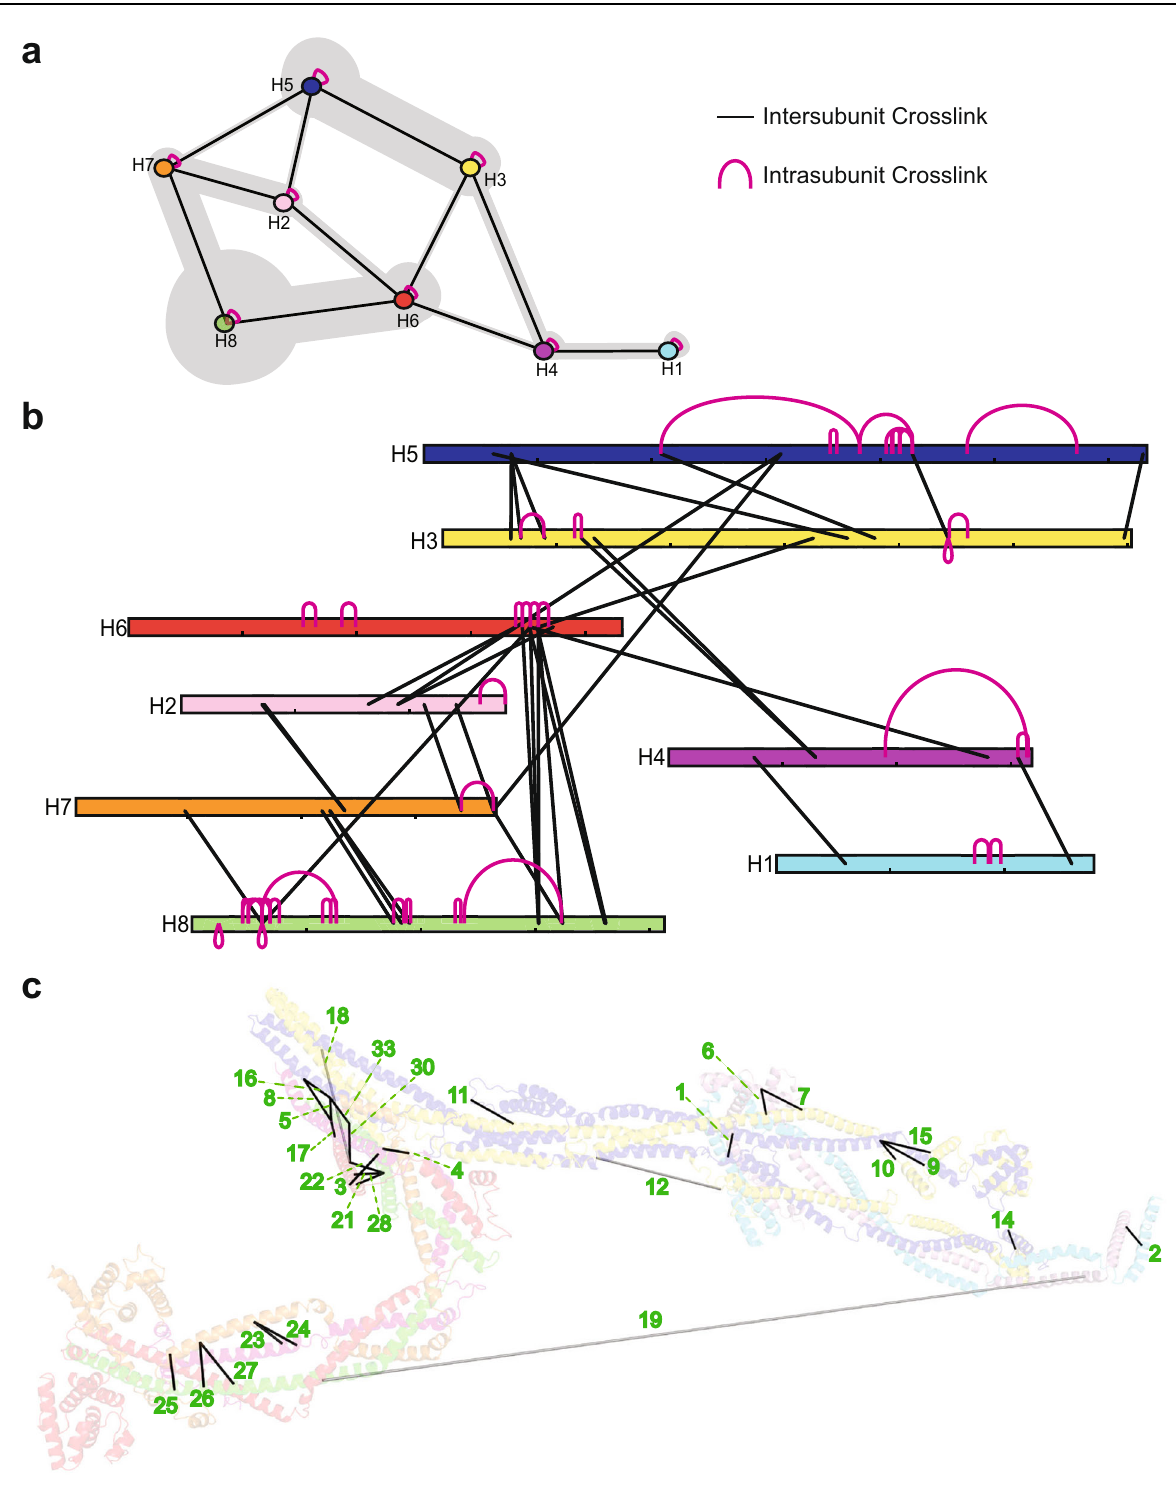
Fig. 3 | Crosslinking mass spectrometry of augmin Δ H6C . a Summary of crosslinks between HAUS subunits. The thickness of gray shading indicates the number of crosslinks. b Relative positions of each individual intrasubunit (pink) and inter- subunit (black) crosslink identi fi ed by CLMS. c Intersubunit crosslinks are mapped